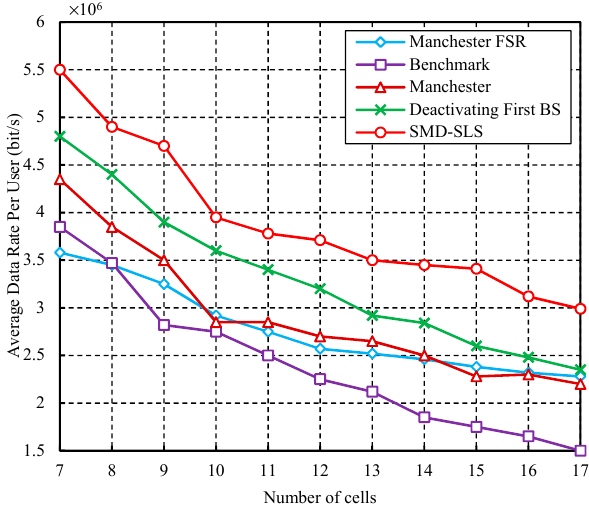
Figure 4. Comparison of average data rate per user with different cell densities.